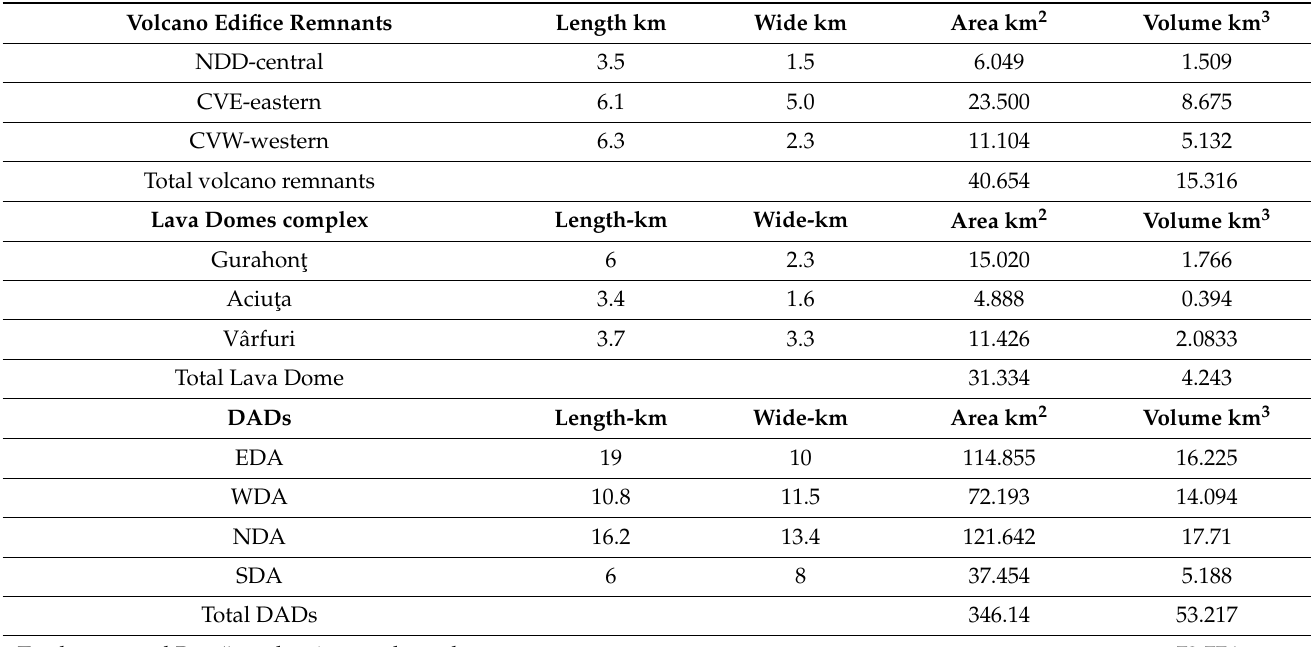
Table 1. Main morphological characteristics of the Bont ă u volcanic complex (the height measurement were averaged for each